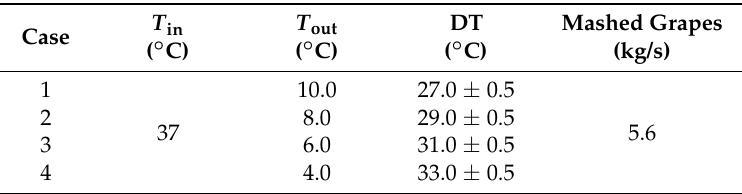
Table 3. Values of the characteristics parameters for the four considered cases T out ( ◦ C) = Final temperature plant set up; T in ( ◦ C) = initial temperature of mashed